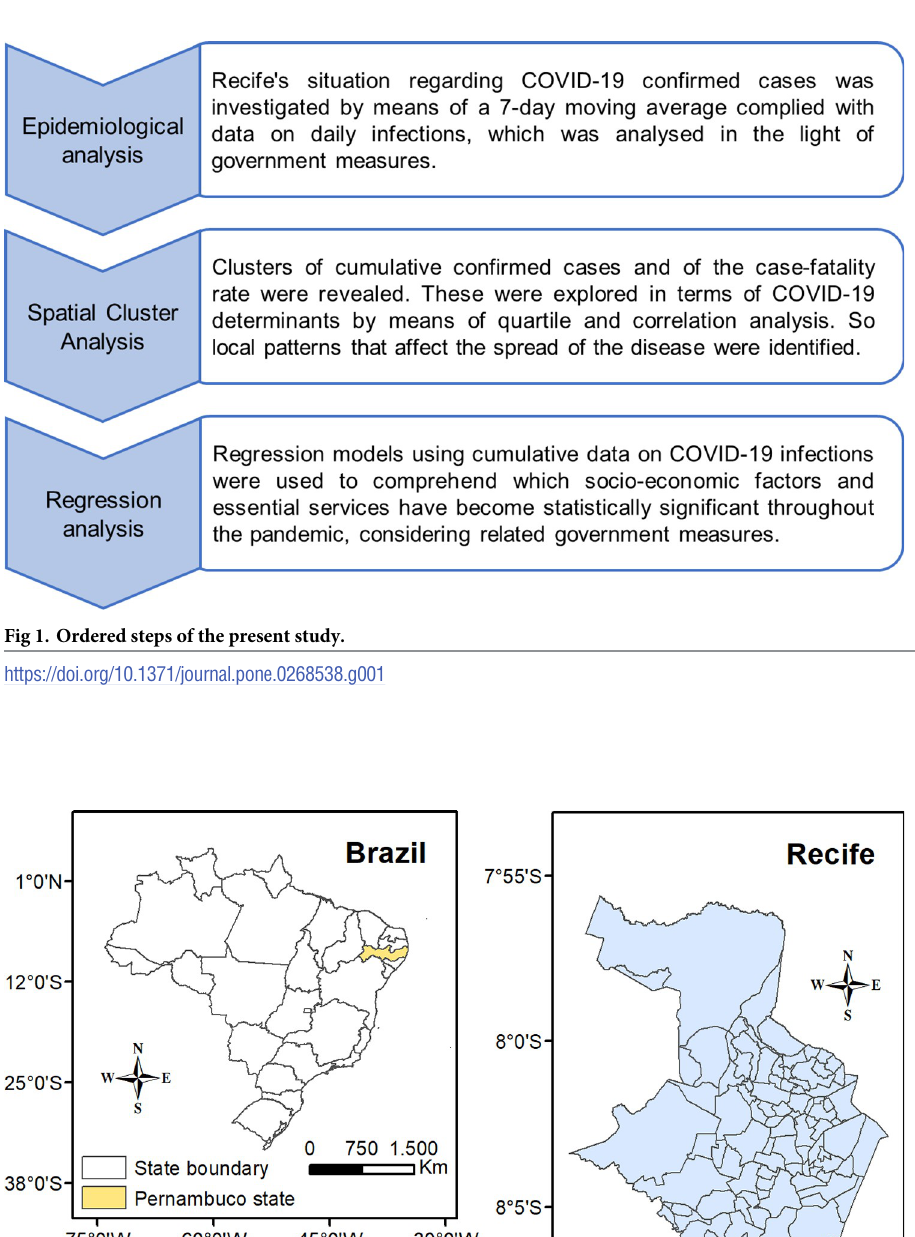
PLOS ONE | https://doi.org/10.1371/journal.pone.0268538 May 17,